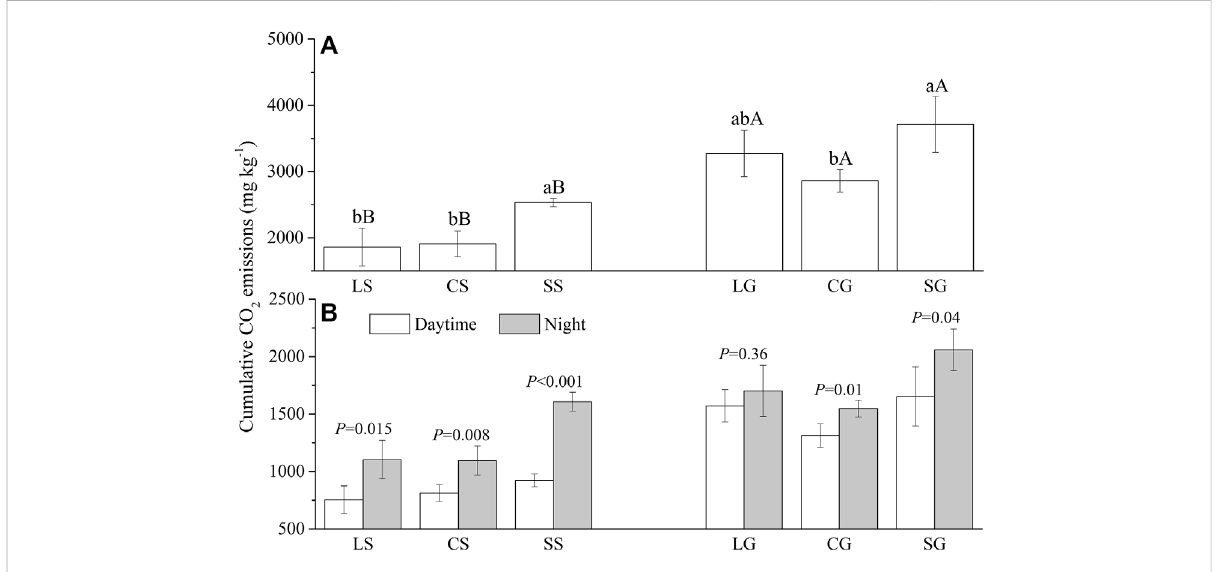
FIGURE 1 Cumulative CO 2 emissions (A) from standing litter and litter on the ground and their distribution at night and in the day (B) . LS, CS, and SS representstandinglitterofleaf,culm,andsheath.LG,CG,andSGrepresentleaf,culm,andsheathlitterontheground. (A) Differentlowercaseletters represent asigni fi cantdifference between three types of litter( p < 0.05). Different capital lettersrepresent thesigni fi cant difference ofthesame litter type between standing litter and litter on the ground ( p < 0.05). (B) p values represent a signi fi cant difference between daytime and night ( p <